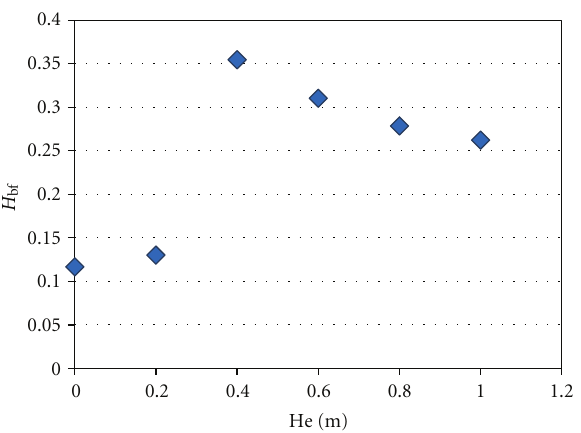
Figure 15: H bf parameter obtained for di ff erent projected heights.